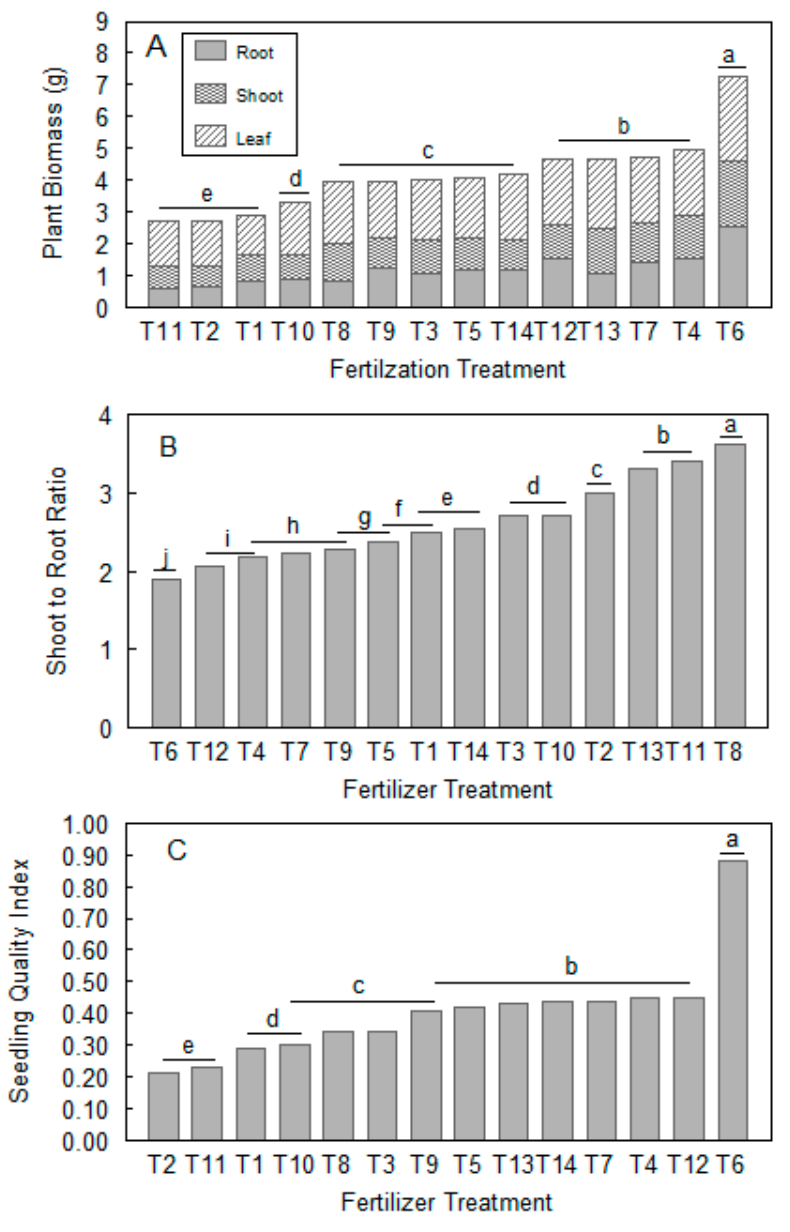
Figure 3. Phoebe bournei seedling growth attributes: ( A ) plant biomass (SE range 0.41 to 0.07); ( B ) shoot to root ratio (SE range 0.18 to 0.01); ( C ) seedling quality index (SE range 0.04 to 0.01). The means for di ff erent fertilization treatments—T1 to T14 as defined in Table 2—are listed in ascending order of treatment response. Treatment means sharing the same letter are not significantly di ff erent at ( p > 0.05), as determined by the Duncan’s multiple range test. Note: Shoot-to-root ratios < 2.5 are considered desirable for good seedling field performance